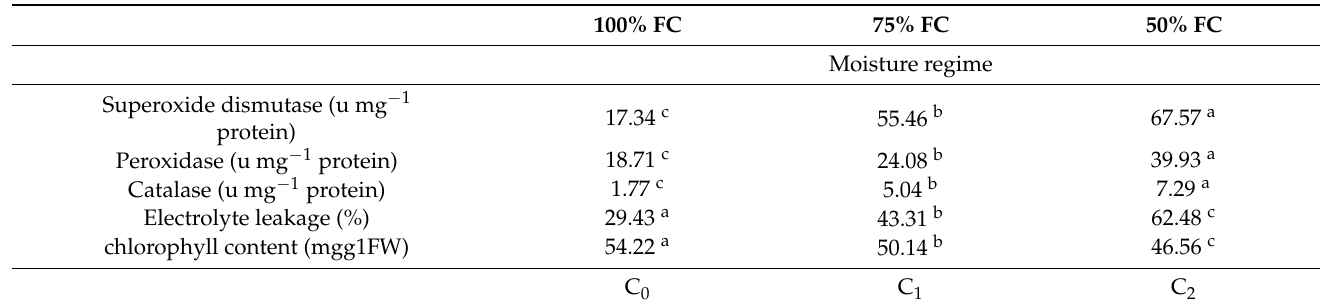
Table 9. Effect of moisture regime, organic coating, and nano titanium dioxide on enzymatic antioxi- dant, electrolyte leakage, and chlorophyll